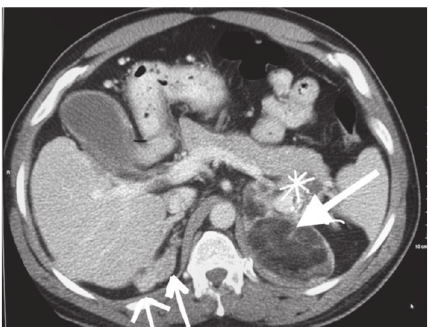
Figure 1: A contrast-enhanced computed tomography (CT) image demonstrating two nodules in the right adrenal gland (small ar- rows) and a large, left adrenal mass with calcifications (large arrow) and suspected invasion of the left adrenal mass into the tail of the pancreas